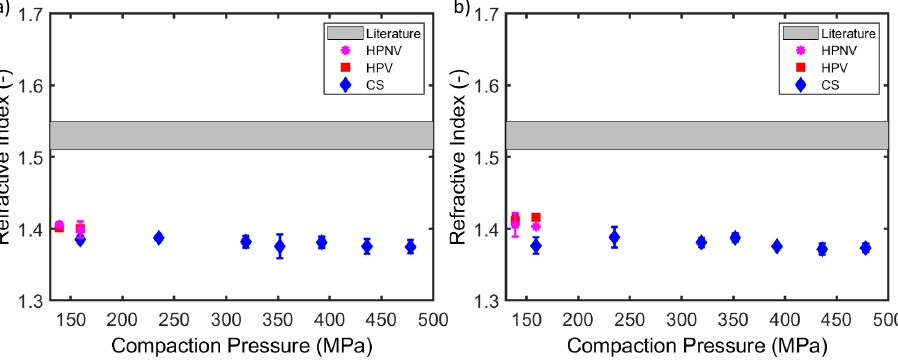
Figure 5. Refractive index extracted at 2.45–2.55 THz for ( a ) HDPE1 and ( b ) HDPE2 pellets compacted at various pressures. Three compaction methods were used: hydraulic press with a vacuum (HPV) and without a vacuum (HPNV) as well as a compaction simulator (CS). Reference values for RI are shown as a grey band. Values plotted are the mean with the error bars depicting ± one standard deviation ( n = 10).